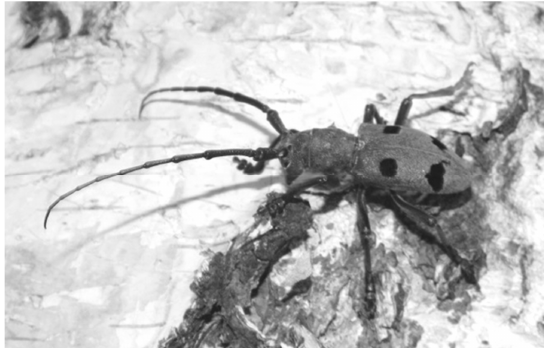
Figure 3. Morimus asper funereus